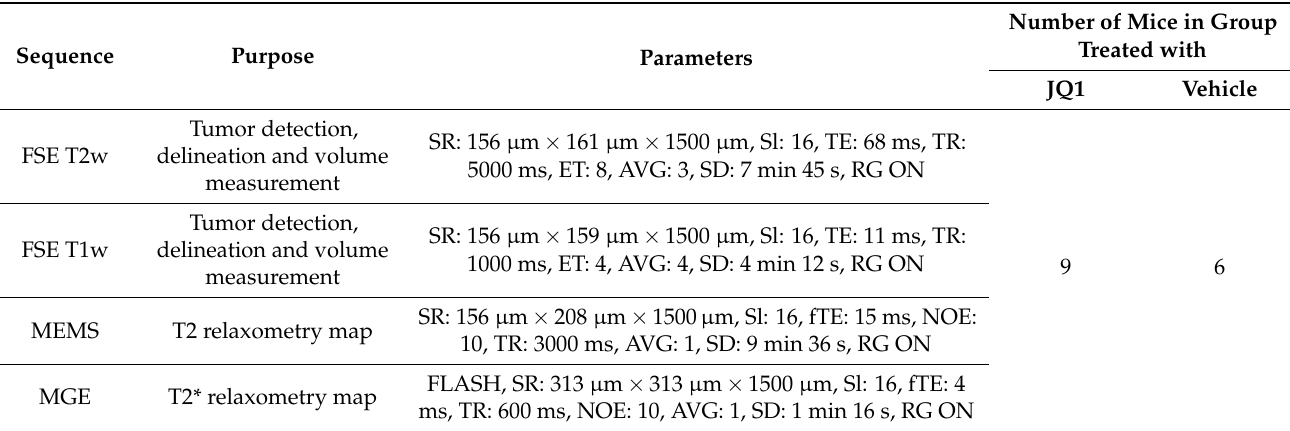
Table 1. MRI protocols used to monitor TH-MYCN tumor